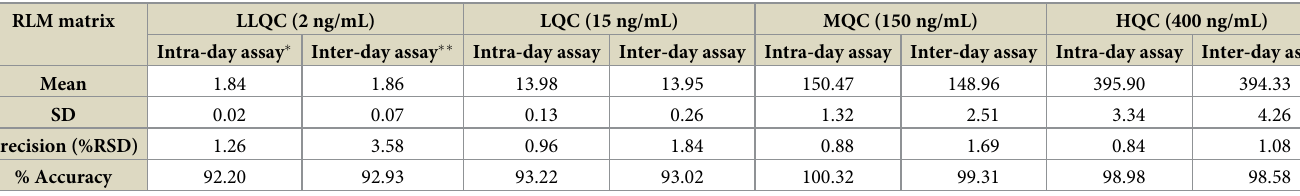
Table 2. Precision and accuracy (intra-day and inter-day) of the developed assays. RLM